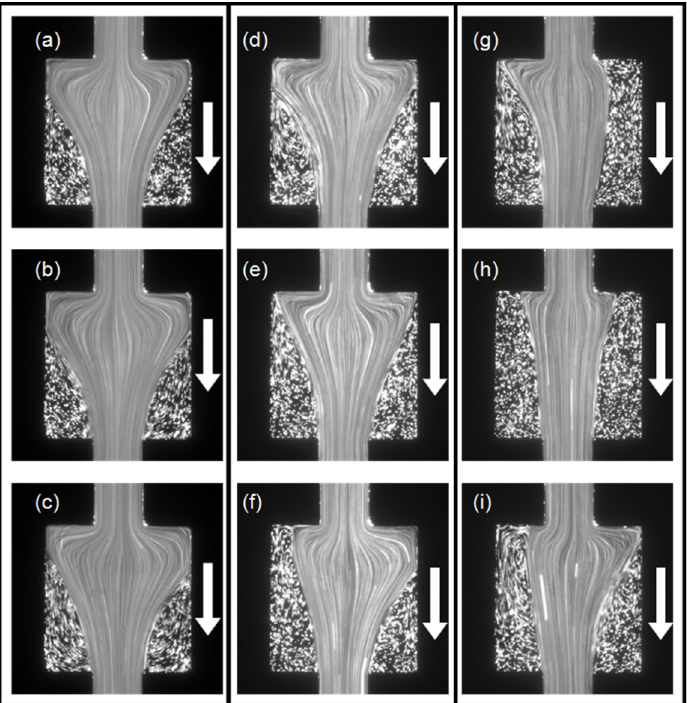
Figure 10. The PAM flow pattern in the symmetric square-only microchannel at three different instants ( a – c ) when Wi = 16.67, ( d – f ) when Wi = 55.56, and ( g – i ) when Wi = 111.11.